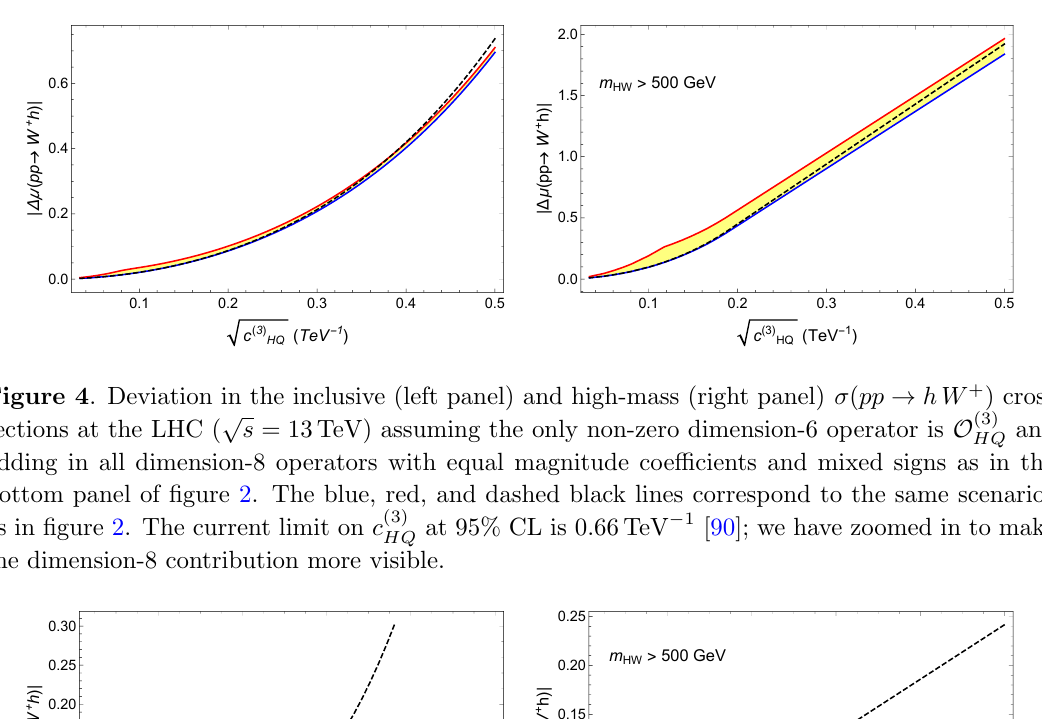
Figure 5 . Deviation in the inclusive (left panel) and high-mass (right panel) (cid:27) ( pp ! h W + ) cross p sections at the LHC ( s = 13 TeV) assuming the only non-zero dimension-6 operator is O adding in all dimension-8 operators with equal magnitude coe(cid:14)cients and the mixed signs as in the bottom panel of (cid:12)gure 2. The blue, red, and dashed black lines correspond to the same scenarios as in (cid:12)gure 2. Current constraints on c are weak, so we have zoomed in to make the dimension-8 H (cid:3) contribution more